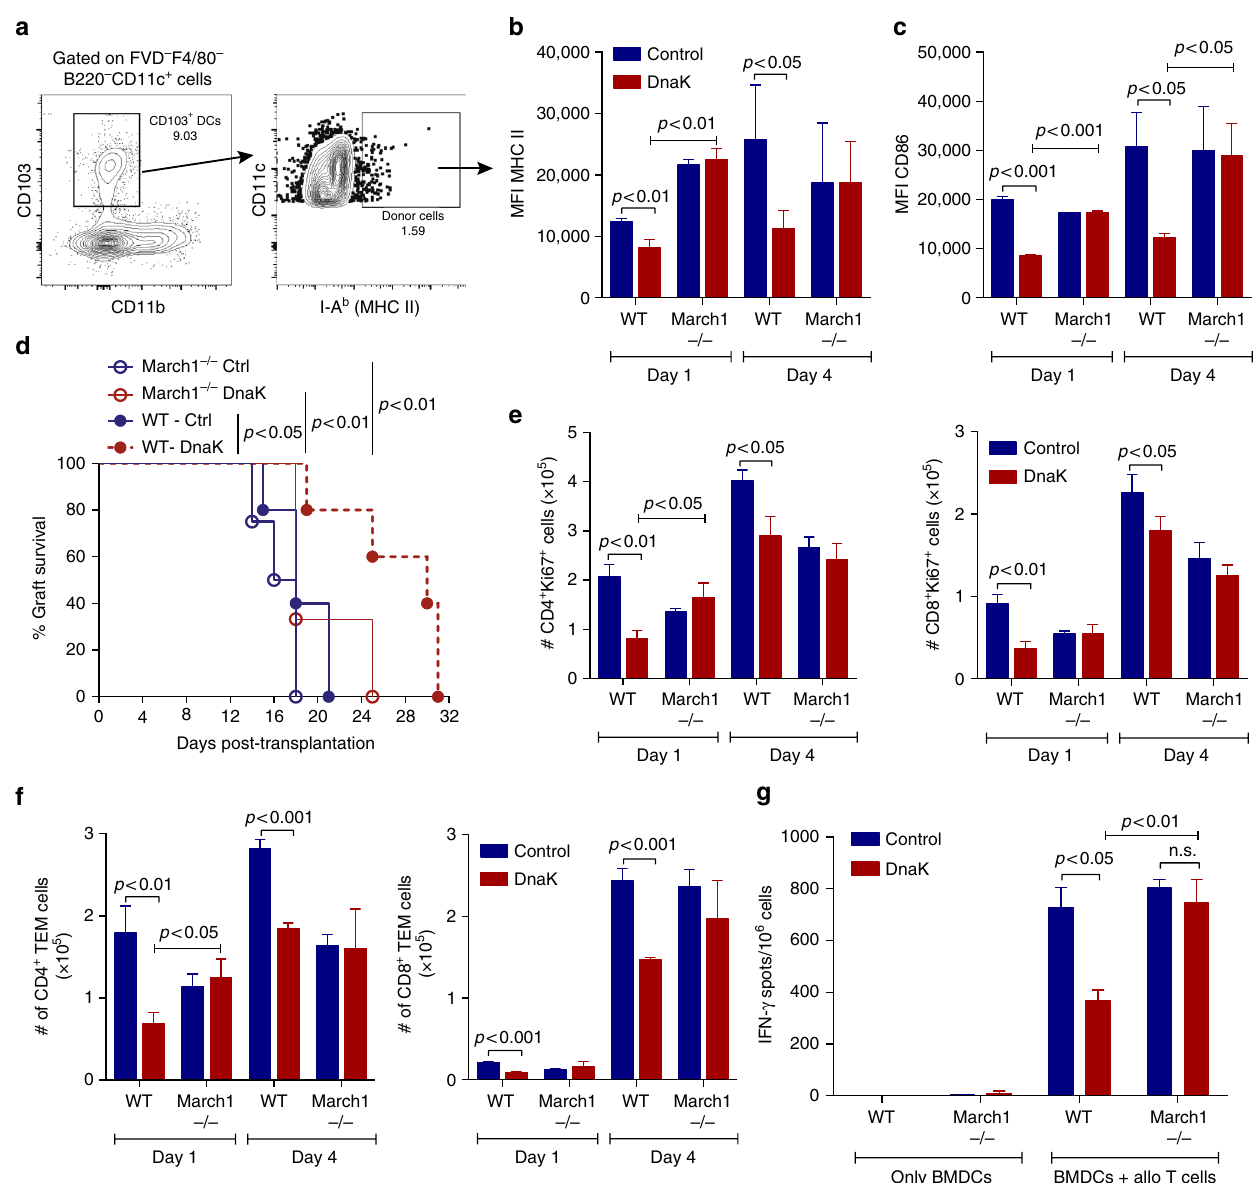
Fig. 6 March1 is required for dampened alloreactivity induced by DnaK. Skin allografts from WT or March1 − / − mice (both H-2K b /I-A b ) were treated with DnaK or control and transplanted into BALB/c (H-2K d /I-A d ) recipients. a Gating strategy for tracking donor MHC II (I-A b ) in cross-dressed host CD103 + DCs. b Donor MHC II (I-A b ) and c CD86 levels in cross-dressed host CD103 + DCs graft dLN at day 1 and 4 post-transplant. d Percent of allograft survival. Statistics using log-rank test ( n = 5/group). e Numbers of CD4 + Ki67 + and CD8 + Ki67 + T cells, and f CD4 + and CD8 + TEM cells from allograft